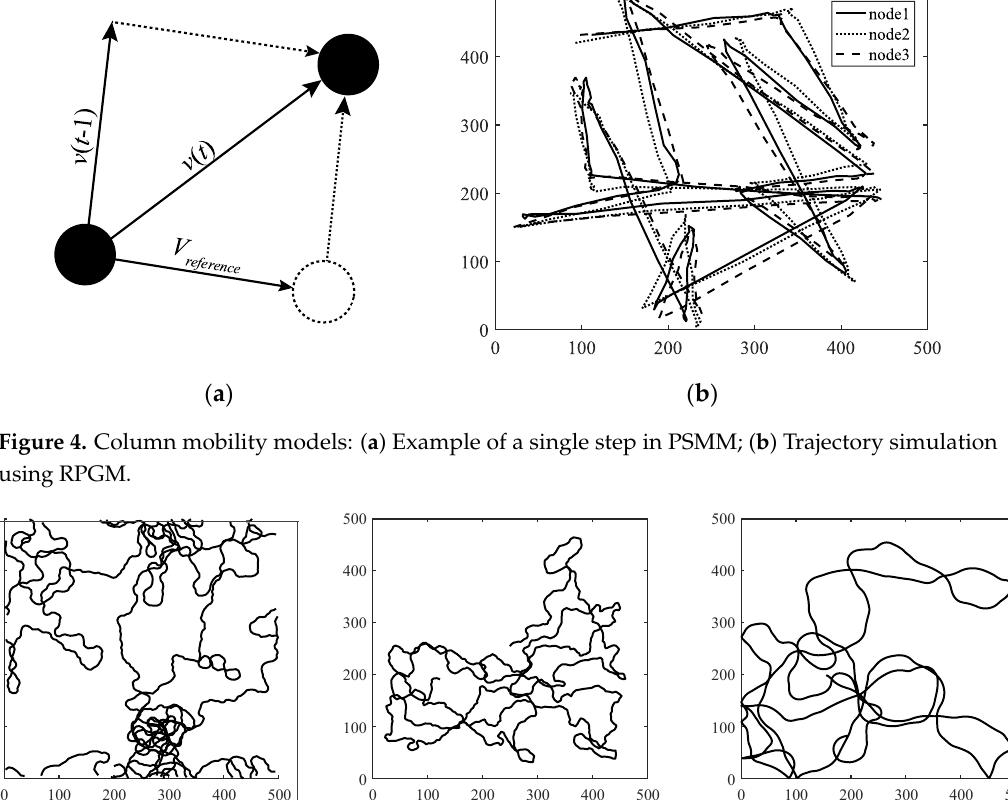
Figure 5. Column mobility models: ( a ) Example of a single step in PSMM; ( b ) Trajectory simulation using RPGM.